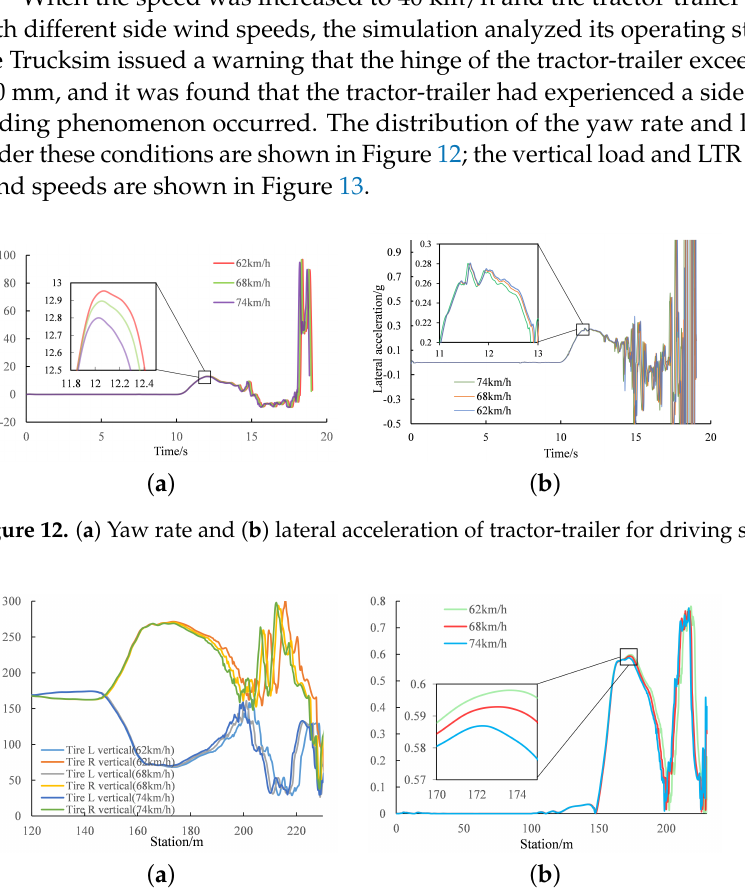
Figure 13. ( a ) Lateral vertical load distribution and ( b ) LTR value of the left and right tire for driving speeds over 40